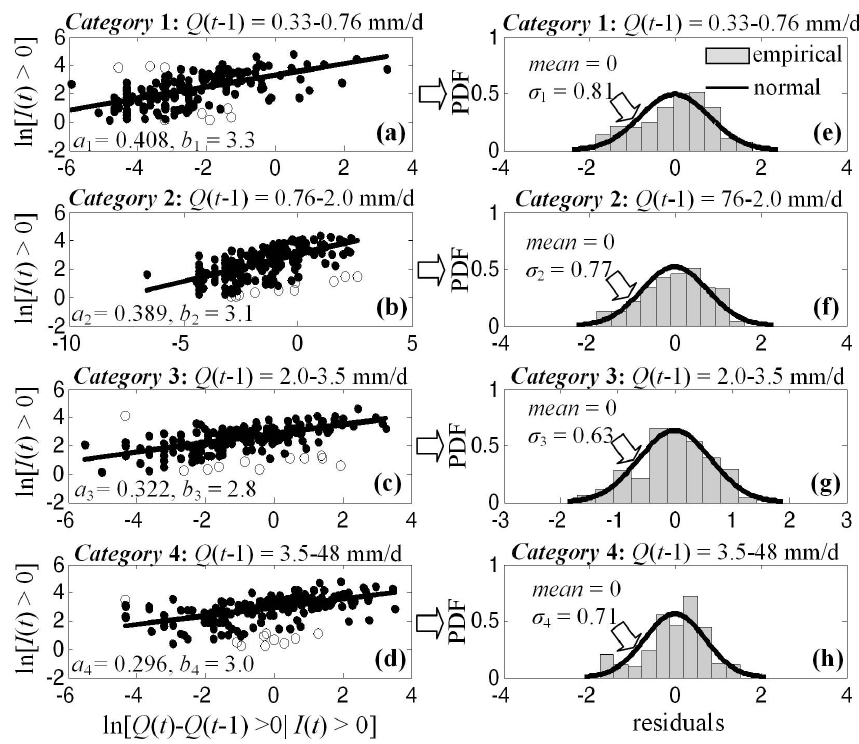
Fig. 8. Same as Fig. 7 but using daily rainfall intensities from Moira station (point C in Fig. 2) for the period 1 October 1975–30 Septem- ber 1993 (i.e. 18yr, 695